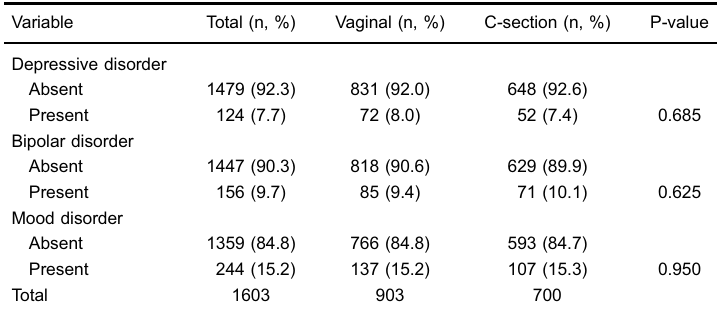
Table 2. Prevalence of mood disorders by delivery type in adolescents.